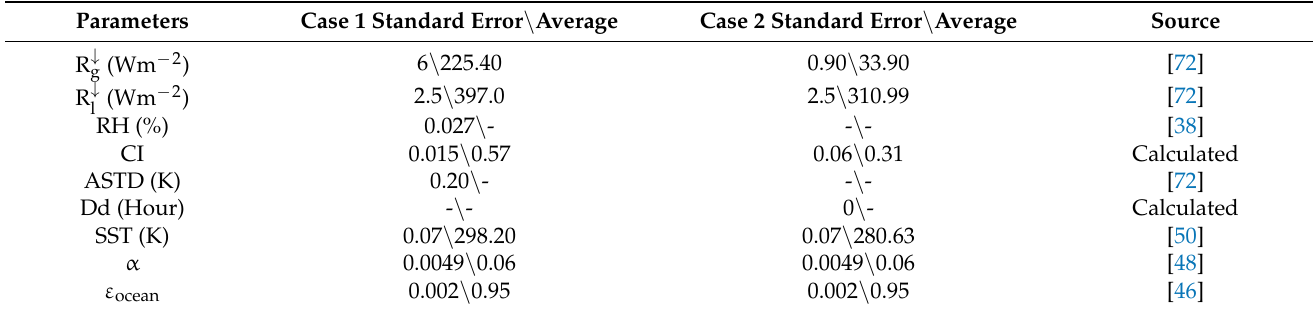
Table 6. The standard error of each